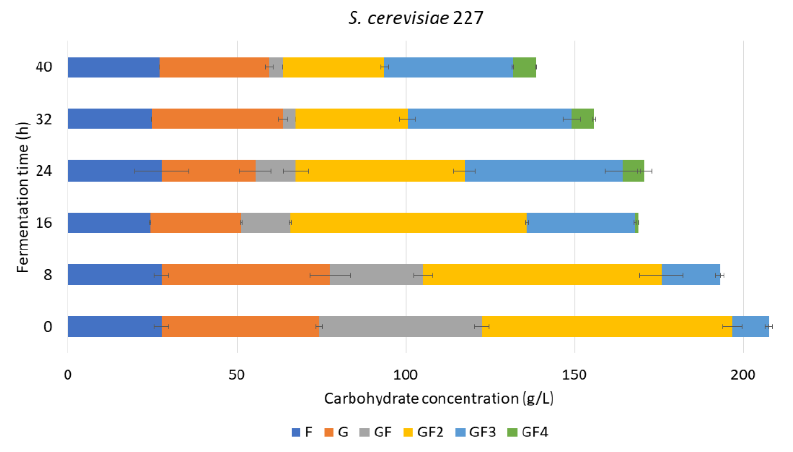
Figure 4. Carbohydrate concentration during successive fermentation with Saccharomyces cerevisiae 227 on AgMe fermentation mixture.